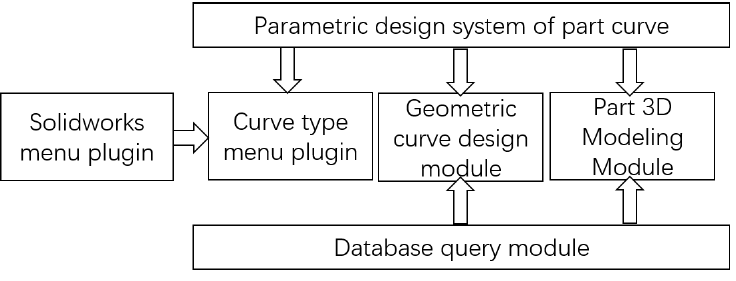
Fig. 4 System master